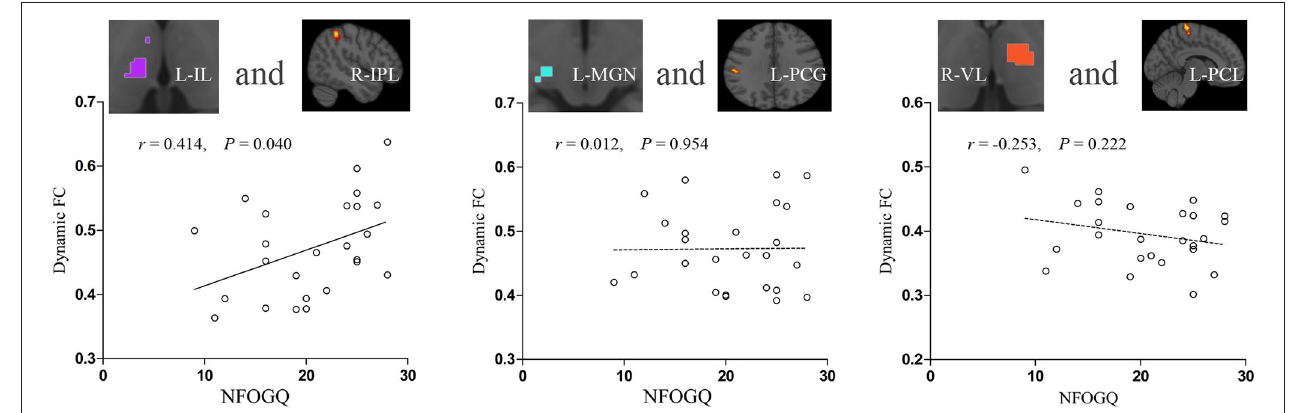
FIGURE 4 | Correlations between increased thalamic dynamic FC and symptom severity in PD-FOG. FC, functional connectivity; IL, intralaminar nuclei; IPL, inferior parietal lobule; L, left; MGN, medial geniculate nuclei; NFOGQ, new freezing of gait questionnaire; PCG, postcentral gyrus; PCL, paracentral lobule; PD-FOG, Parkinson’s disease patients with freezing of gait; R, right; VL, ventral lateral